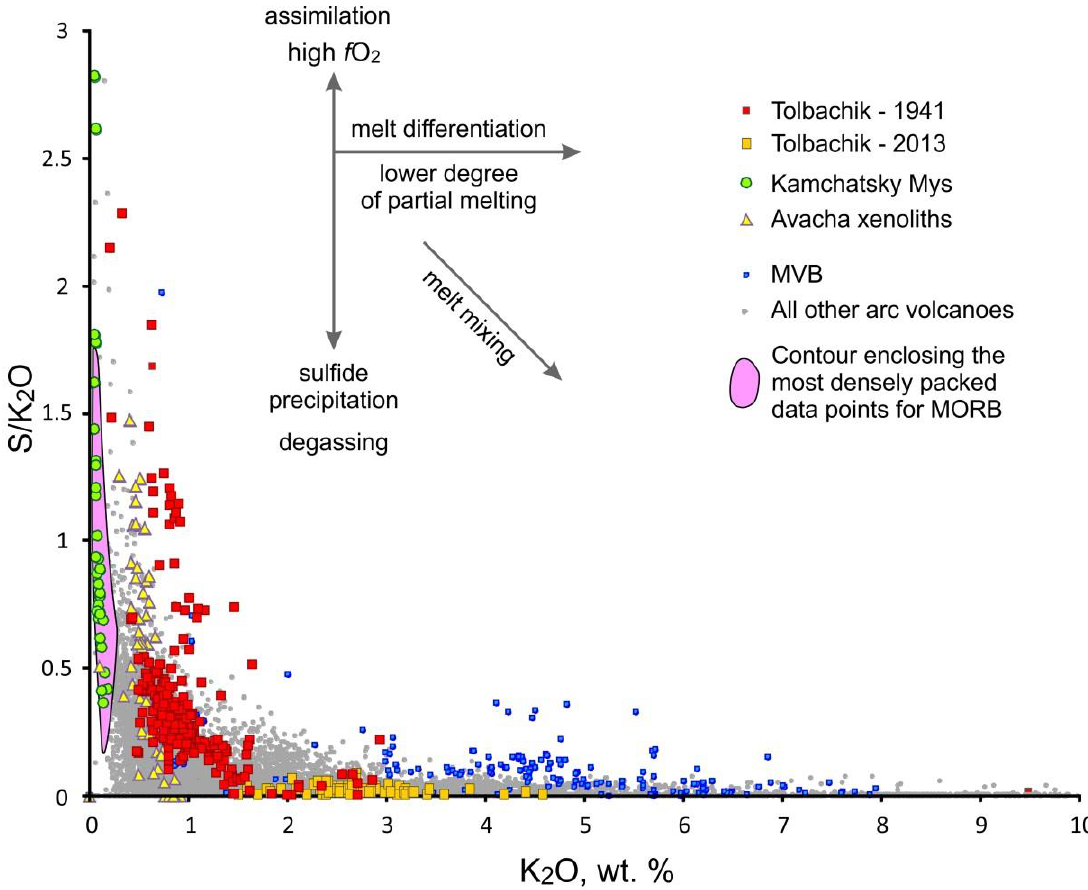
Figure 11. Variation diagram for K 2 O (wt.%) vs. S/K 2 O for MI from arc volcanoes here and worldwide (sourced from the GEOROC database).